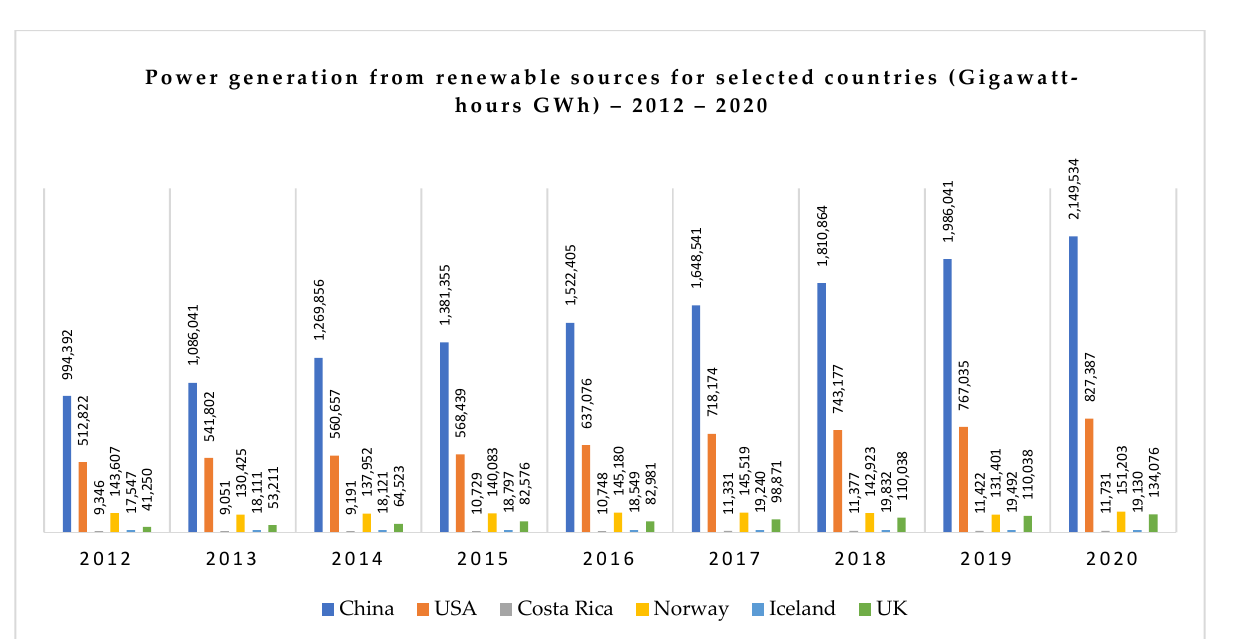
Figure 4. Actual power generation from renewable sources for selected countries (Gigawatt hours GWh)—2012–2020 Source: the authors centralized and adapted data published by ref. [177].